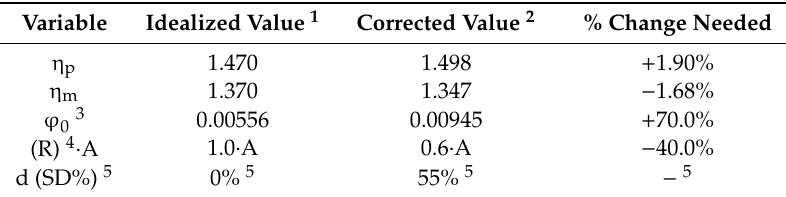
Table 1. Analysis of single variable changes that would be necessary for explaining the experimental correction